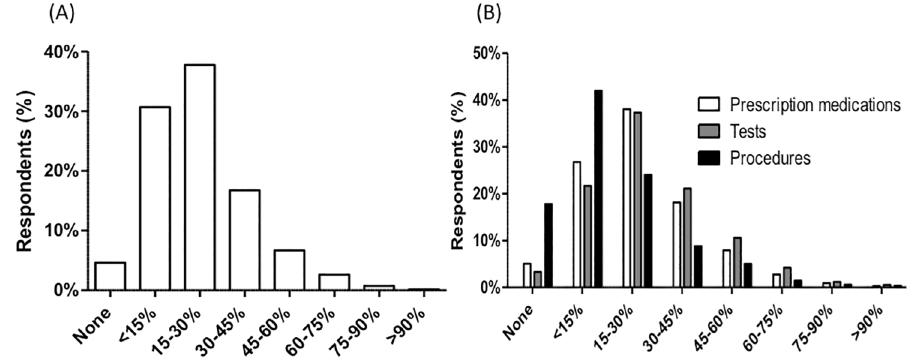
Fig 1. Physician perceptions on overtreatment. (A) Percentage of Overall Medical Care Considered Unnecessary (N = 2,106) (B) Percentageof Medical Care Considered Unnecessary by Type (N = 2,106).